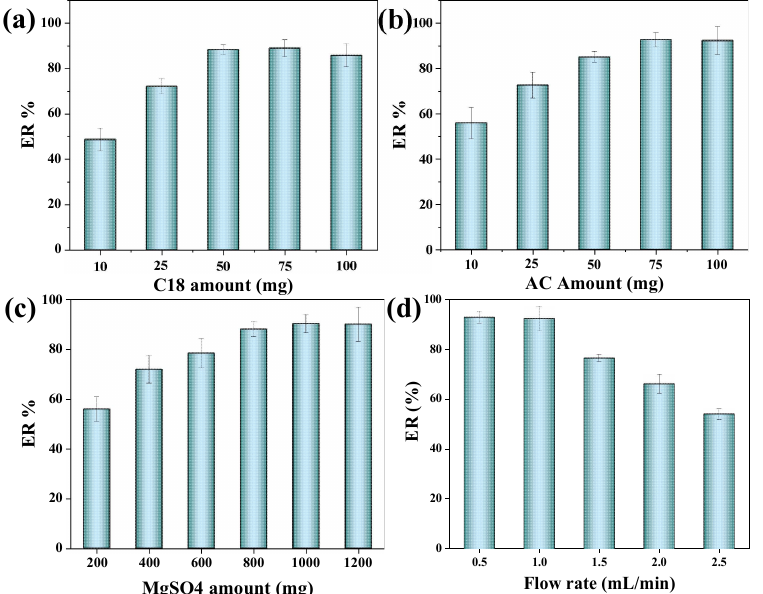
Figure 3. ( a ) Selection of C 18 amount, ( b ) Selection of AC amount and ( c ) Selection of MgSO 4 amount, and ( d ) Selection of plunger speed for the extraction of OTA from coffee samples. Extraction conditions: 250 mg coffee, 0.5 mL water, 2.0 mL solvent, 2.5 min of vortex extraction, and clean-up under the flow rate of 0.5 mL/min using the 1000 mg MgSO 4 , 75 mg AC and 50 mg C18 with three replicate analyses.